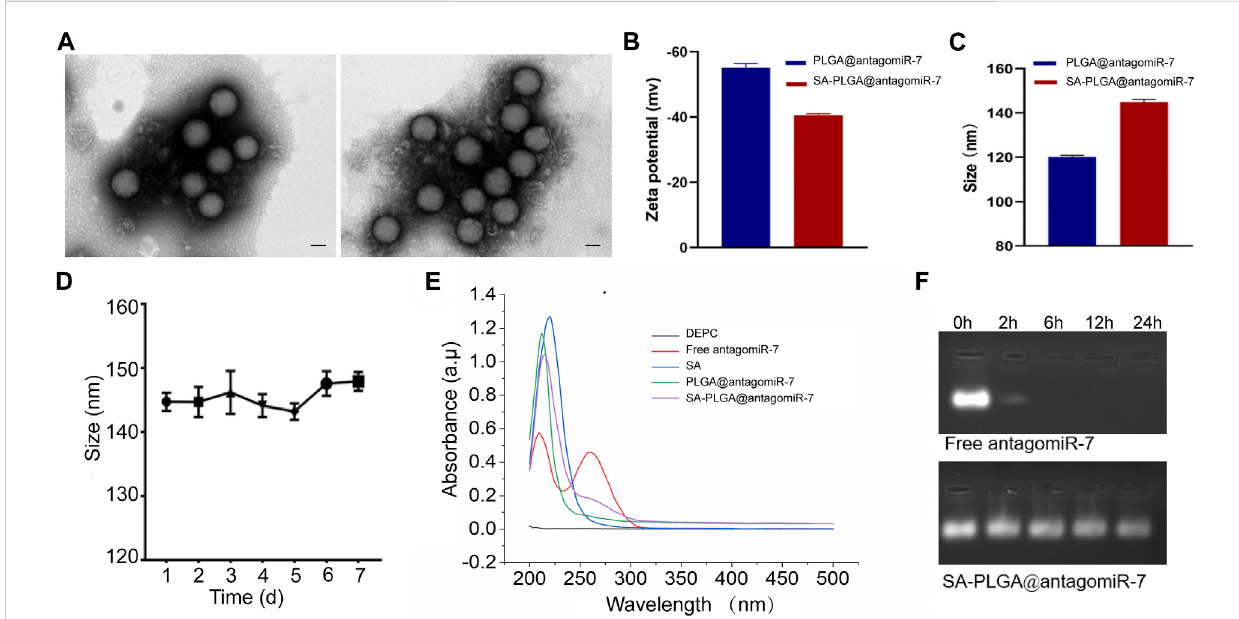
FIGURE 1 (A) TEM images of PLGA@antagomiR-7 (Left) and SA-PLGA@antagomiR-7 (Right). (Scale bar, 100 nm) (B) Zeta potential and (C) hydrodynamic diameter of PLGA@antagomiR-7 and SA-PLGA@antagomiR-7. (D) The particle size of SA-PLGA@antagomiR-7 within 1 week. (E) UV – vis absorption spectra. (F) Free antagomiR-7 or SA-PLGA@antagomiR-7 was incubated with RNAase A at different time points, and then the miRNA level in indicated groups was examined by electrophoresis on an agarose